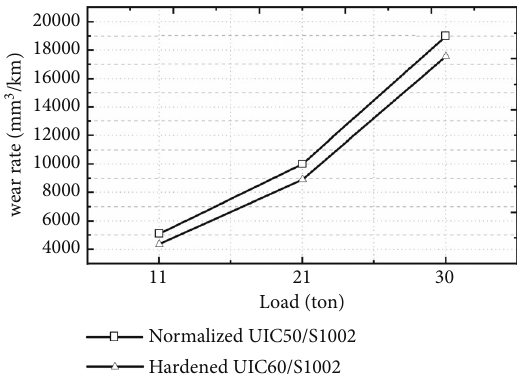
Figure 9: Wear rate values of wheel material on normalized and hardened rail/wheel